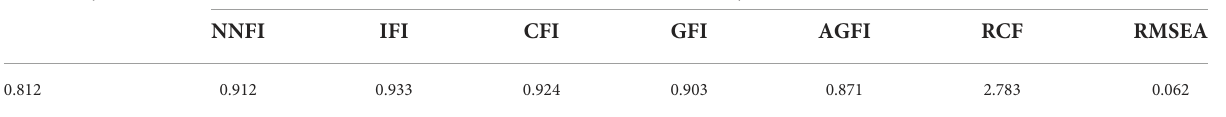
TABLE 3 Reliability and validity of questionnaire.